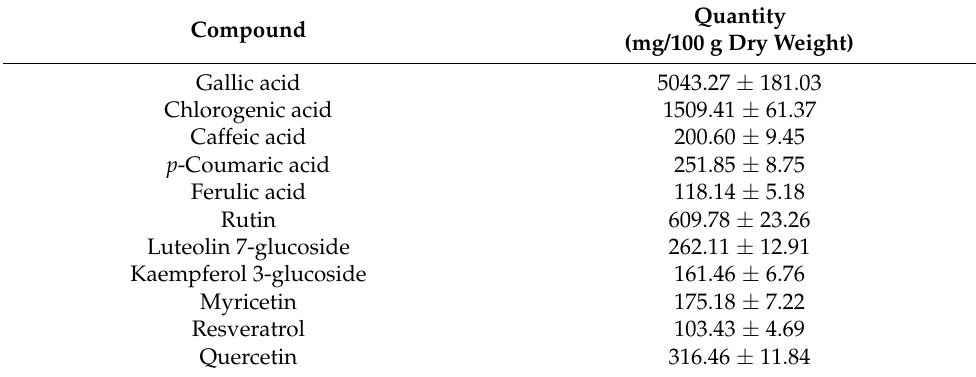
Table 2. HPLC analysis of phenolic compounds in blueberry pomace extract. The results are expressed as mean ± SD ( n =